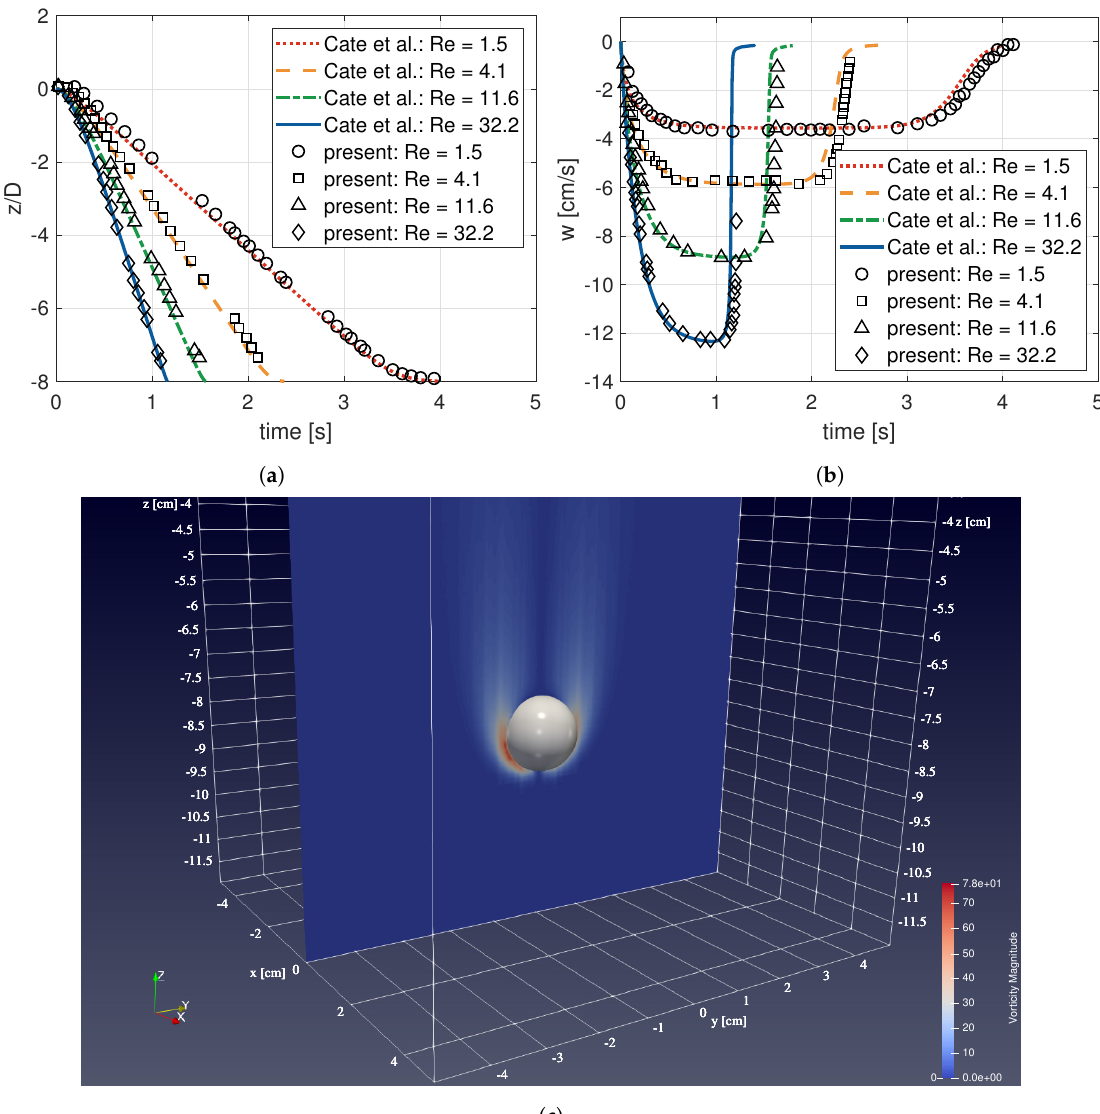
Figure 4. Time traces of sphere’s ( a ) vertical position and ( b ) vertical velocity compared with [16]. ( c ) A snapshot of vorticity magnitude contours at t = 0.9 with Re =